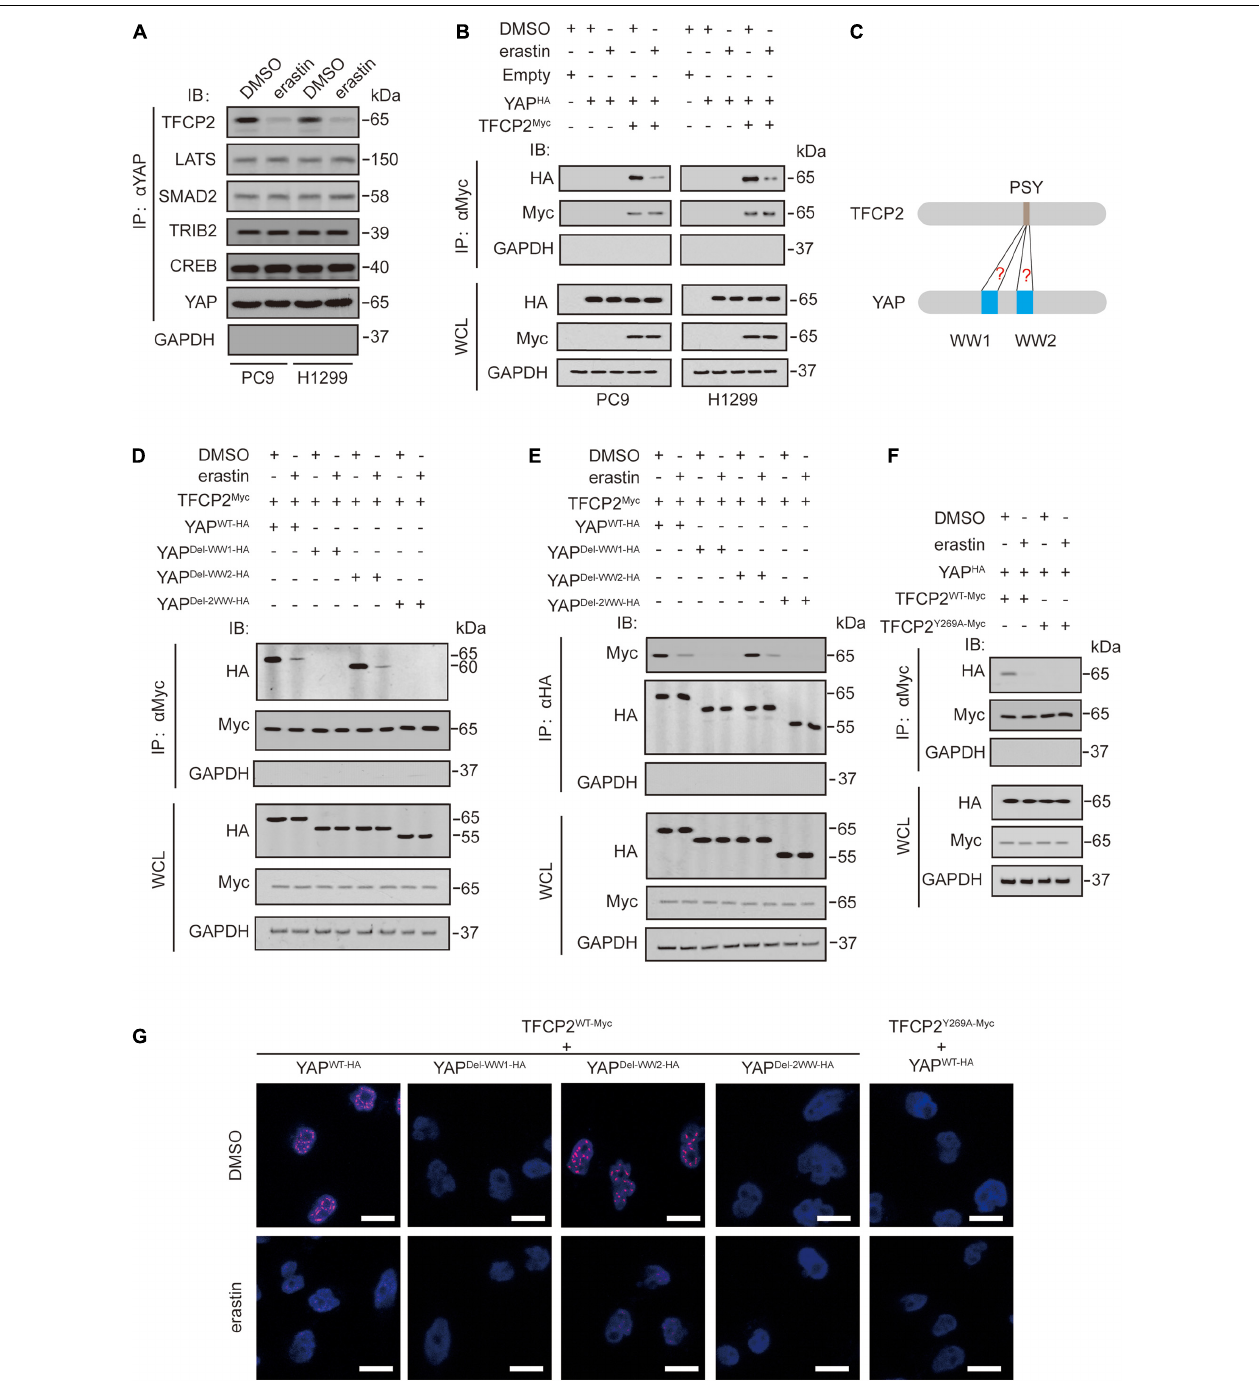
FIGURE 1 | Erastin inhibits YAP and TFCP2 interaction. (A) A Co-IP experiment was performed using anti-YAP antibodies in control cells and PC9 or H1299 cells with or without erastin (10 µ M, 24 h) treatment. The YAP level in each co-IP samples was adjusted to the same protein content. The interaction between YAP and TFCP2, LATS, SMAD2, TRIB2, and CREB were measured using the indicated antibodies by IB. (B) A Co-IP experiment was performed using anti-Myc antibodies in control cells and PC9 or H1299 cells with the indicated vectors transfected before erastin (5 µ M, 4 h) treatment. The indicated proteins in co-IP samples or WCL were measured by IB. (C) Schematic representation for interactions between the PSY motif of TFCP2 and the WW domains of YAP. (D–F) Co-IP experiments were performed using anti-Myc (D,F) and anti-HA (E) antibodies in PC9 cells with the indicated vectors transfected before erastin (5 µ M, 4 h) treatment. The TFCP2-Myc (D,F) and YAP-HA (E) level in each co-IP samples was adjusted to the same protein content. The indicated proteins in co-IP samples or WCL were measured by IB. (G) PLA experiments were performed using anti-Myc and anti-HA antibodies in PC9 cells with indicated vectors transfected before erastin treatment (5 µ M, 4 h). Scale bar, 50 µ m. Images of IB are representative ones of 3 independent